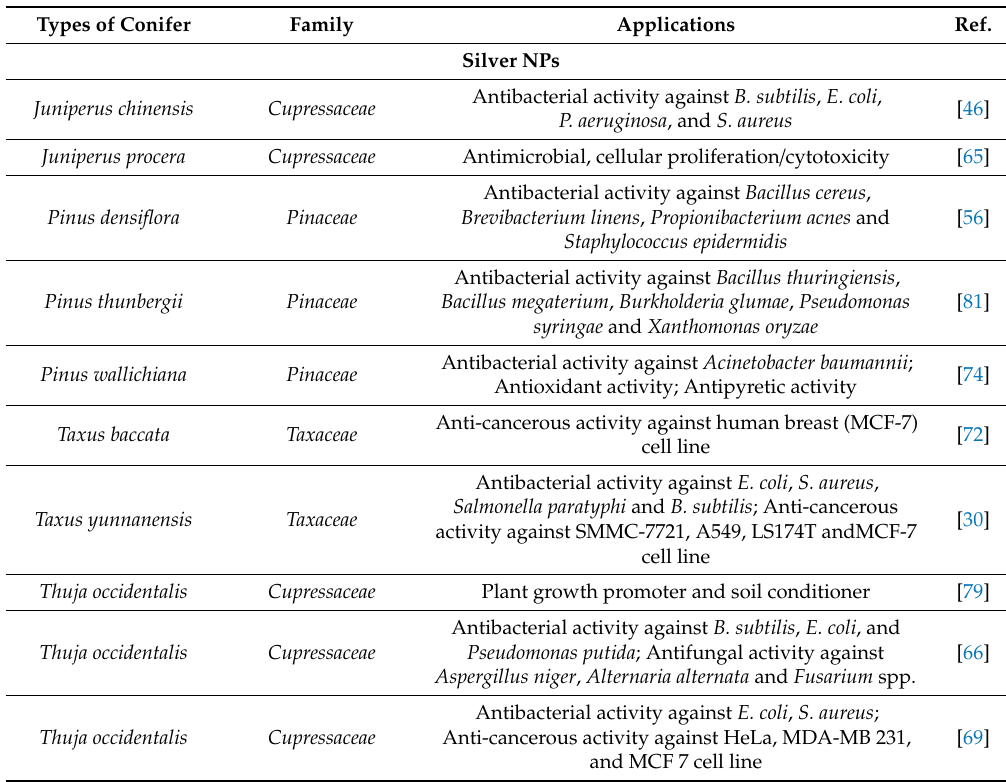
Table 2. Agricultural and biomedical applications of conifer plant extract derived metal (Ag and Au)